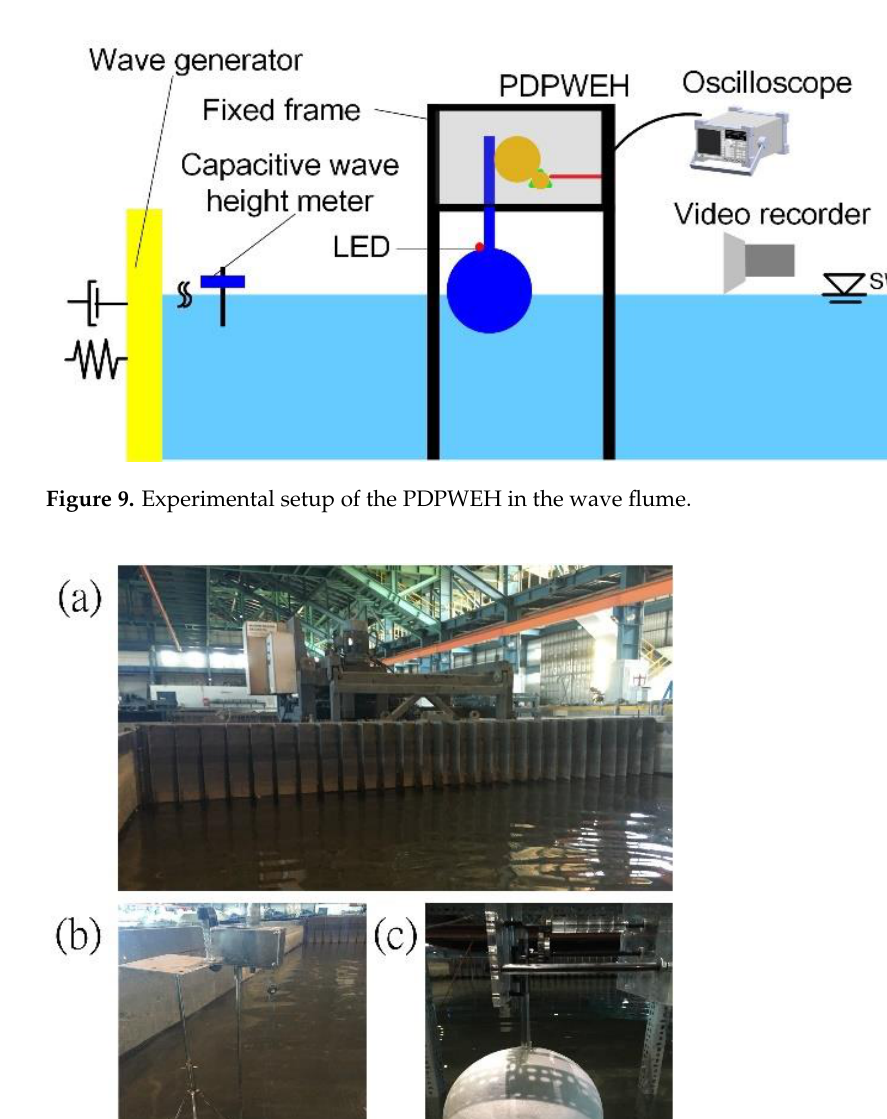
Figure 10. Image of the experimental devices. ( a ) Wave generator ( b ) capacitive wave height meter ( c ) PDPWEH.